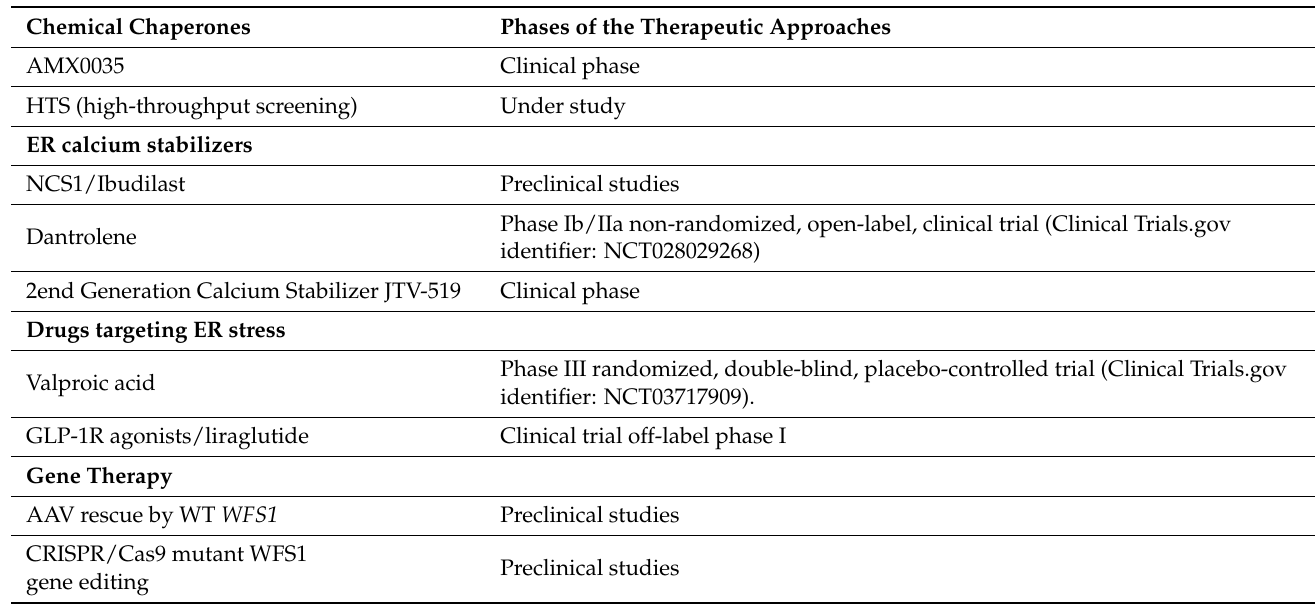
Table 4. Development stages of therapeutic strategies proposed for Wolfram syndrome